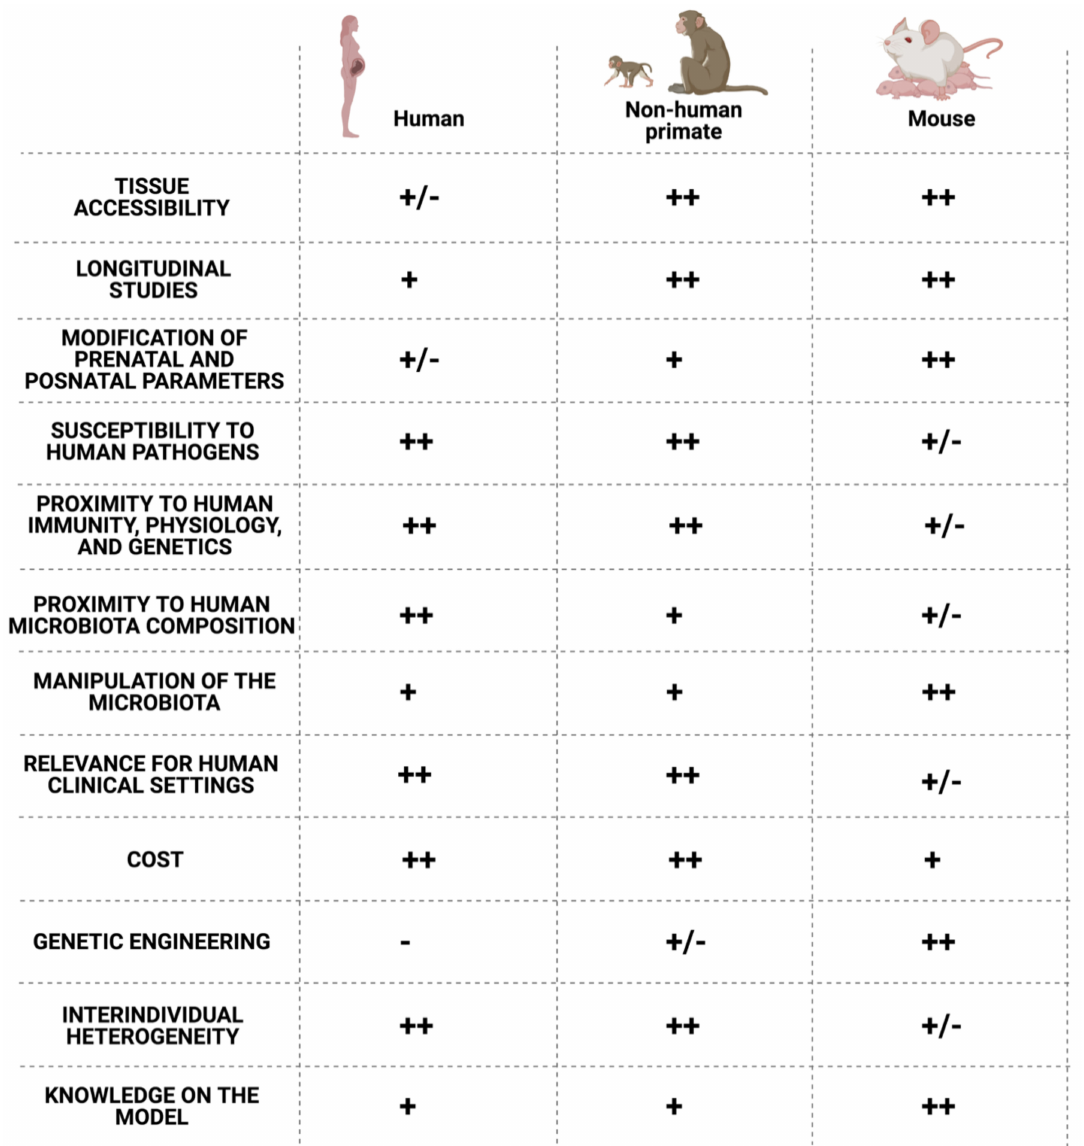
Figure 4. Comparison of the non-human primate and mouse models to the human. Created by BioRender.com, accessed on 20 April